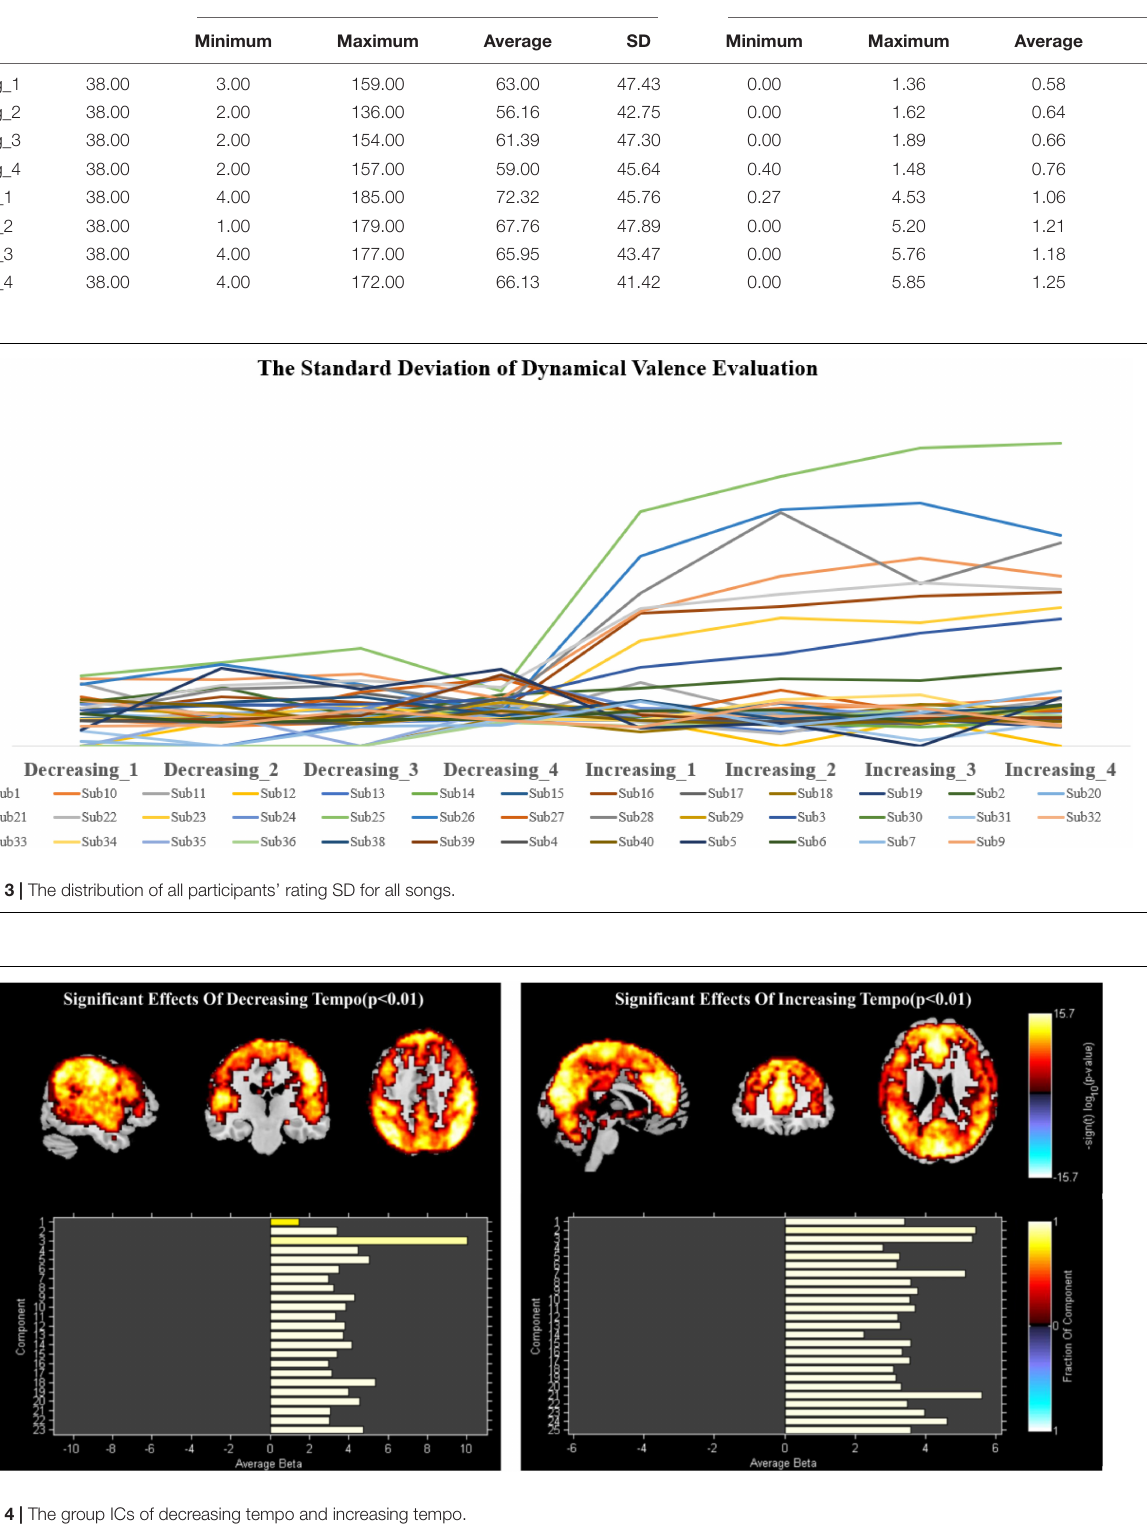
FIGURE 4 | The group ICs of decreasing tempo and increasing